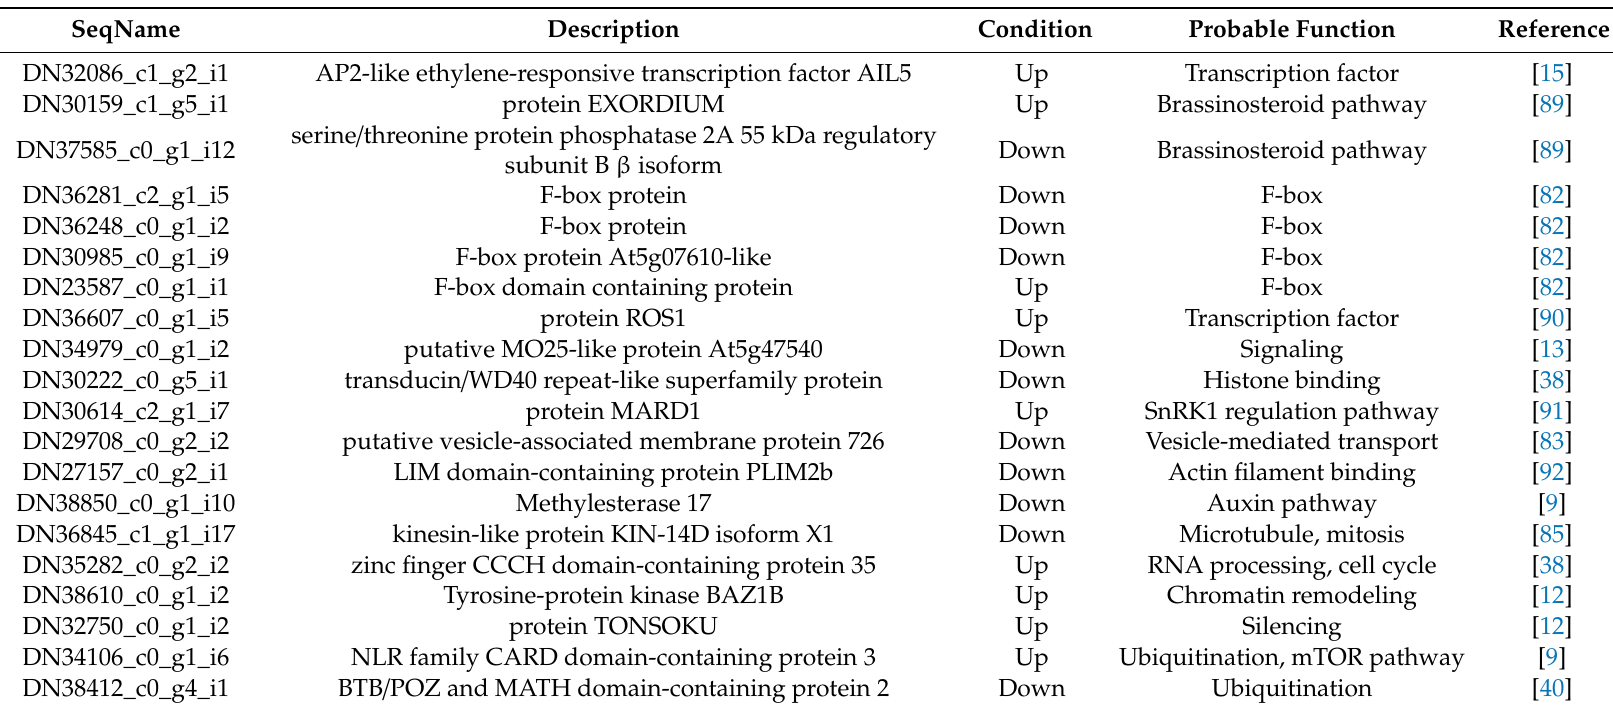
Table 3. Di ff erentially expressed transcripts reported by di ff erent authors in di ff erent apomictic species compared with their sexual